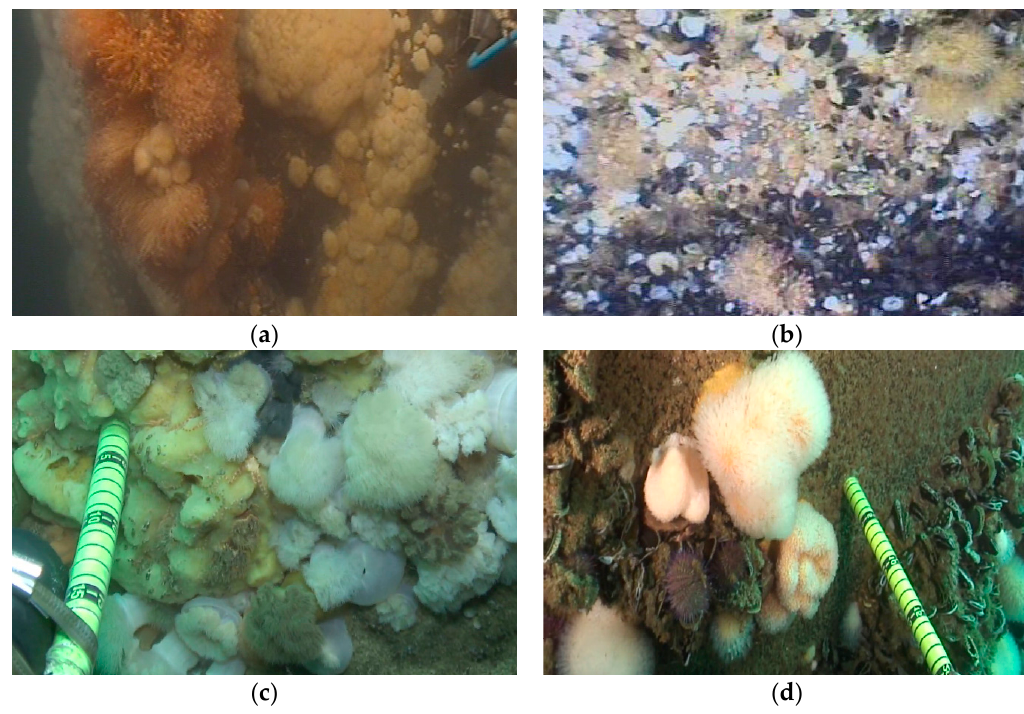
Figure 5. Representative images collected from offshore structure ROV surveys. ( a , b ) represent typical quality footage which may not be suitable for use in CoralNet; ( c , d ) represent the best quality images that can be gathered from offshore ROV surveys.